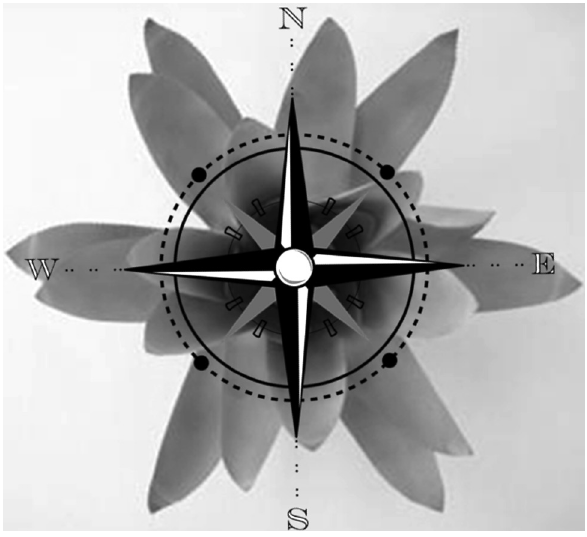
Figure 1. Illustration demonstrating how we collected the data regarding cardinal directions on bromeliads (used here for exempli- fication), stems, and trunks in Grussaí. We obtained the pictures of the bromeliad and of the wind rose from the World Wide Web and overlapped the second over the first for the composition of the whether the lizards were randomly oriented or not. We also performed circular-circular correlations to test whether lizards’ orientations on different substrates (bromeliads, other perches, and on all types) were correlated with the direction of the sun.